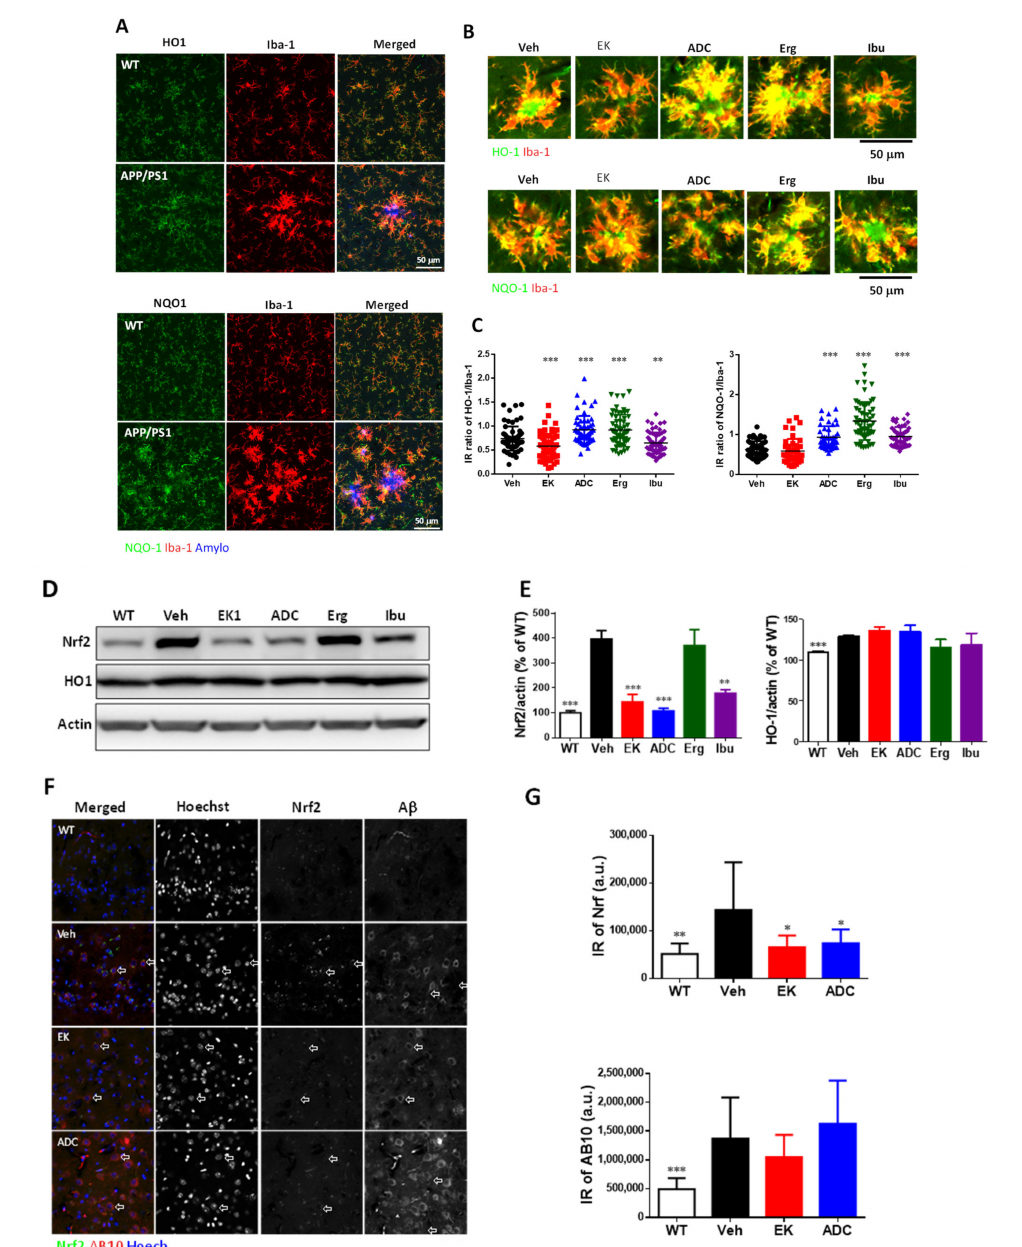
Figure 6. Antrodin C, but not EK100, promotes HO-1 in APP/PS1 mice. ( A – E ). APP/PS1 transgenic mice orally administered vehicle (Veh) or EK100 (EK), antrodin C (ADC), ergosterol (Erg), and ibuprofen (Ibu) (30 mg · kg − 1 · day − 1 , each n = 6) for 1 month. The representative images of HO-1 (green in upper panel) and NQO1 (green in lower panel) in Iba-1 + microglia (red) of WT mice and APP/PS1 transgenic mice are shown in ( A ). Amyloid plaques were stained with Amylo-Glo (blue). Scale bar: 50 µ m. The representative images of HO-1 (green in upper panel) and NQO1 (green in lower panel) in Iba-1 + microglia (red) of APP/PS1 transgenic mice are shown in ( B ). Immunointensity (IR) ratio of HO-1/Iba-1 and NQO-1/Iba-1 are calculated and shown in ( C ). Representative immunoblots of Nrf2 and HO-1 and β -actin of cortical homogenate are shown in ( D ). The protein level in wild-type (WT) mice ( n = 6) is also compared. The ratio of Nrf2 and HO-1 to β -actin is presented as a percentage of the WT group ( E ). ( F , G ) APP/PS1 transgenic mice orally administered vehicle (Veh) or EK100 (EK) and antrodin C (ADC) (30 mg · kg − 1 · day − 1 , each n = 6) for 1 months. The representative images of Nrf2 (green in merged panel) and AB10 (red in merged panel) in neurons of WT mice and APP/PS1 transgenic mice are shown in ( F ). Nuclei staining using Hoechst 33258 (blue). Scale bar: 20 µ m. Immunointensity (IR) of Nrf2 and AB10 were calculated and shown in ( G ). The results are the mean ± S.E.M. Significant differences between the Veh group and the other groups are indicated by *, p < 0.05; **, p < 0.01; ***, p <